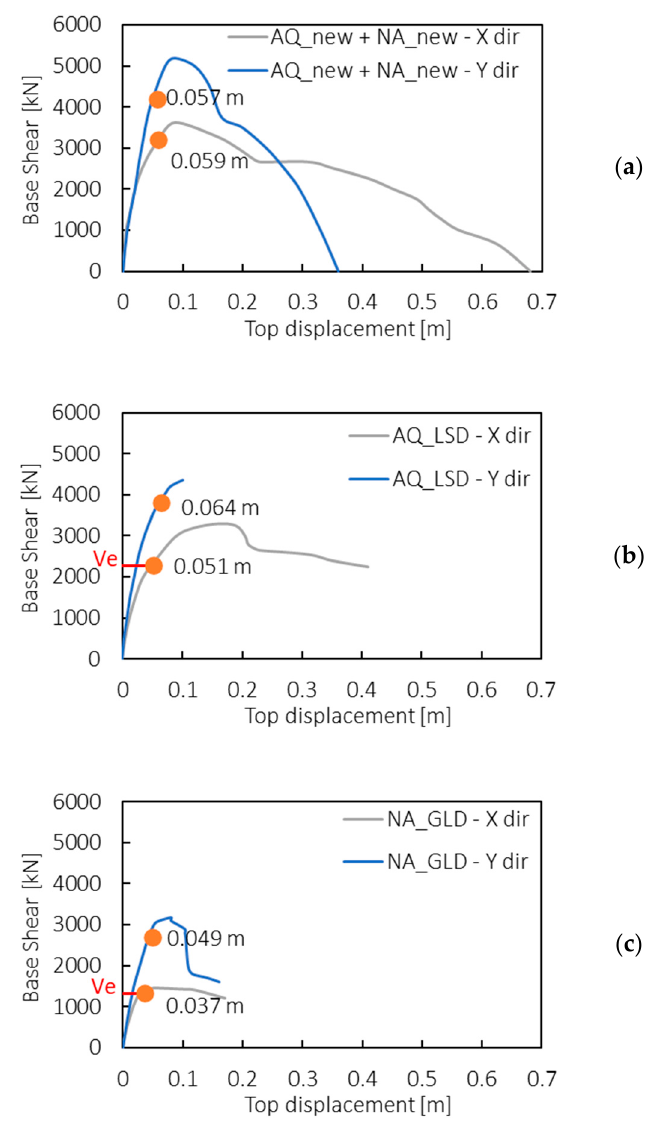
Figure 9. Limit values of top displacement associated with the attainment of the Usability-preventing Performance Level, as derived from Pushover analysis for new construction buildings ( a ), and existent buildings in the sites of L’Aquila ( b ) and Naples ( c